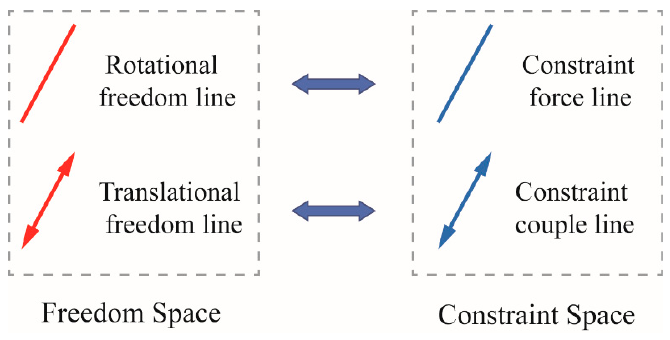
Figure 6. A unit screw.